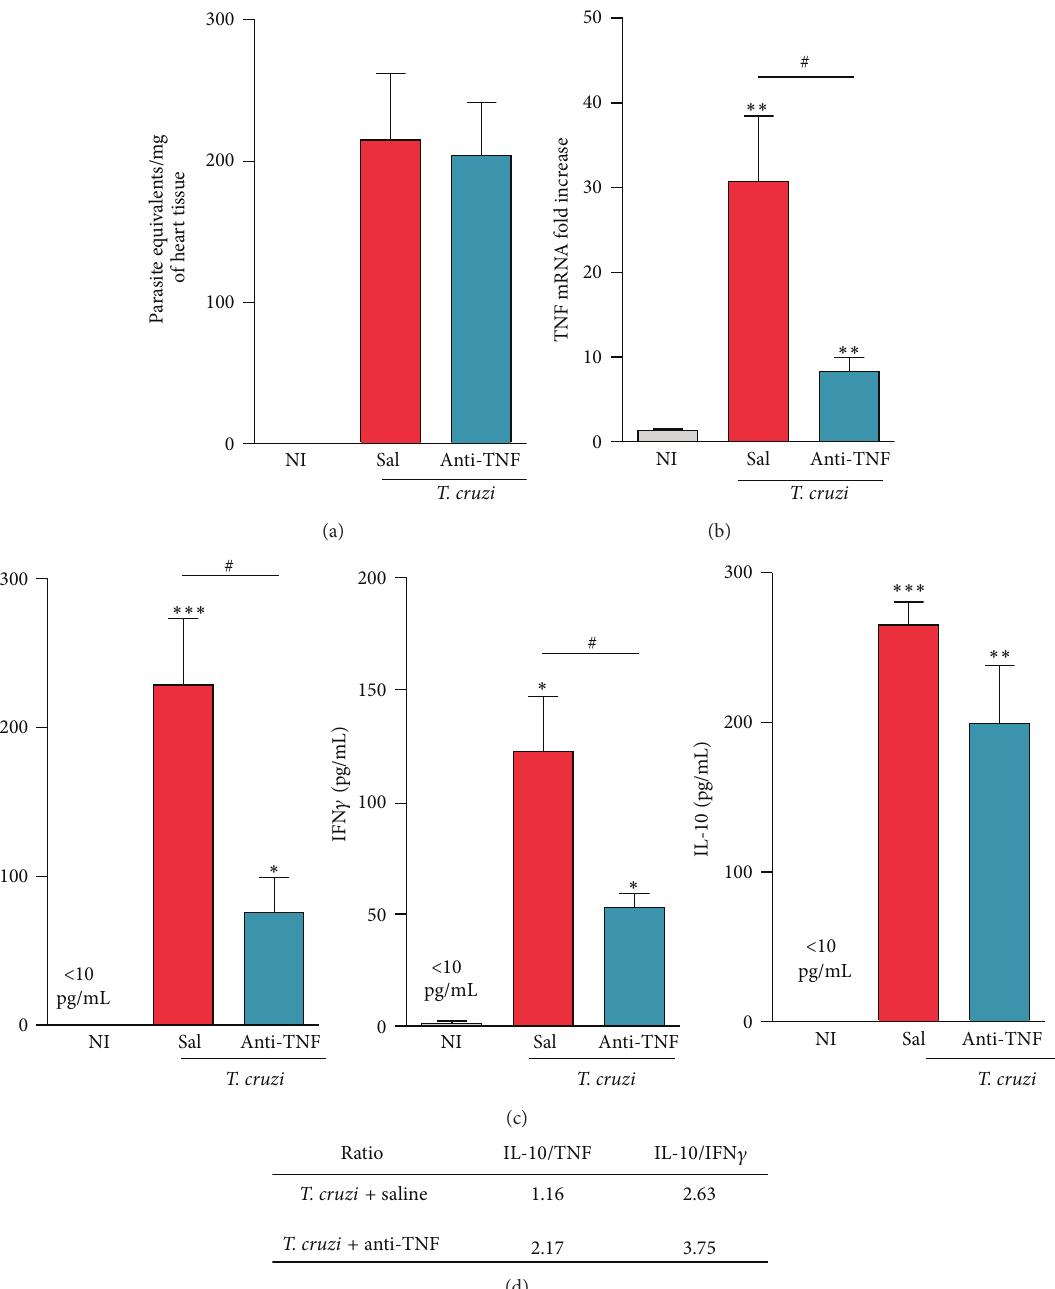
Figure 2: Therapy with Infliximab does not reactivate Trypanosoma cruzi but reduces TNF mRNA expression in the heart tissue and inflammatory cytokine profile in the serum of chronically infected mice. C57BL/6 mice infected with 100 bt of the Colombian T. cruzi strain were treated from 120 to 150dpi and analyzed at 150dpi. (a) Detection of parasite DNA (equivalents/mg) in the cardiac tissue. (b) Expression of TNF mRNA (fold increase) in the heart tissue. (c) Measure of cytokine concentrations in the serum. (d) Relative ratios of IL-10/TNF and IL-10/IFN 𝛾 levels in the serum in saline-injected and anti-TNF treated infected mice. ∗ 𝑃 < 0.05 , ∗∗ 𝑃 < 0.01 , and ∗∗∗ 𝑃 < 0.001 , T. cruzi - infected mice (saline injected or anti-TNF treated) compared to NI controls. # 𝑃 < 0.05 , anti-TNF-treated compared to saline-injected T. cruzi -infected mice. Bar represents the mean ± SD of the studied group (3 to 5 mice). These data represent three independent